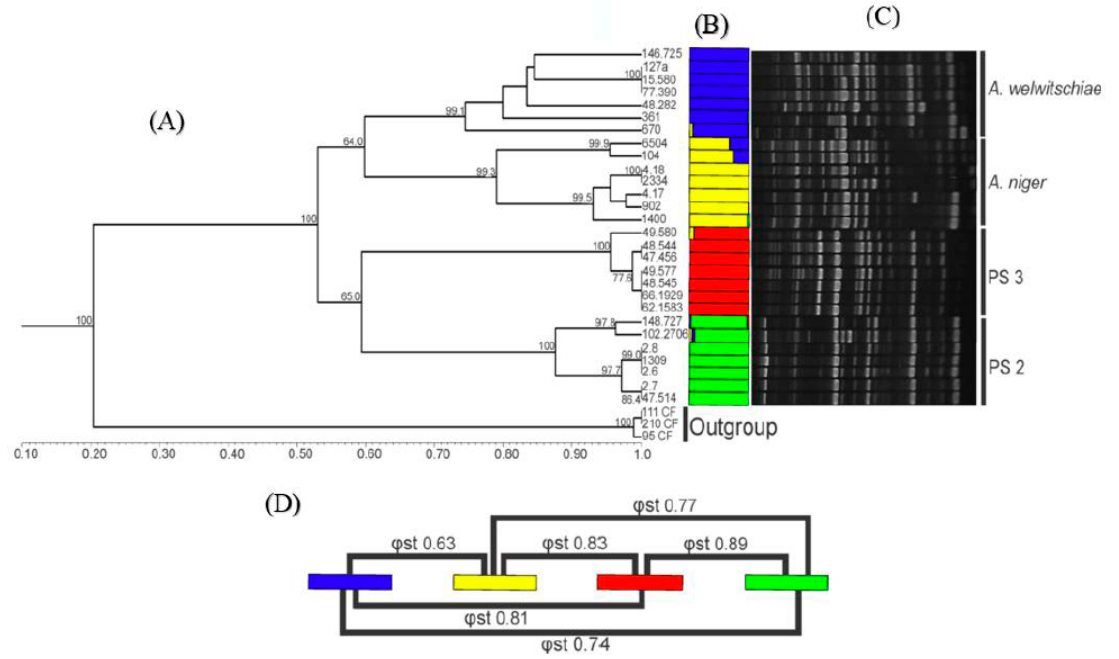
Figure 3. Cluster analysis based on Random Amplified Polymorphic DNA (RAPD) markers. PS2 = Phylogenetic species 2, PS3 = Aspergillus vinaceus sp. nov. Each colour corresponds to a genetic group ( K = 4). ( A ) Unweighted Pair Group Method with Arithmetic Mean (UPGMA) dendrogram obtained using the Dice similarity coefficient using A. carbonarius strains as the outgroup. ( B ) Bayesian analysis (Structure bar plot). ( C ) RAPD profile representative, OPAM 07 primer. ( D ) Pairwise φ st index.